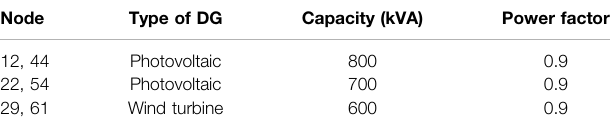
TABLE 2 | Types and parameters of DG. TABLE 3 | Reliability parameters of components in the AC/DC hybrid distribution